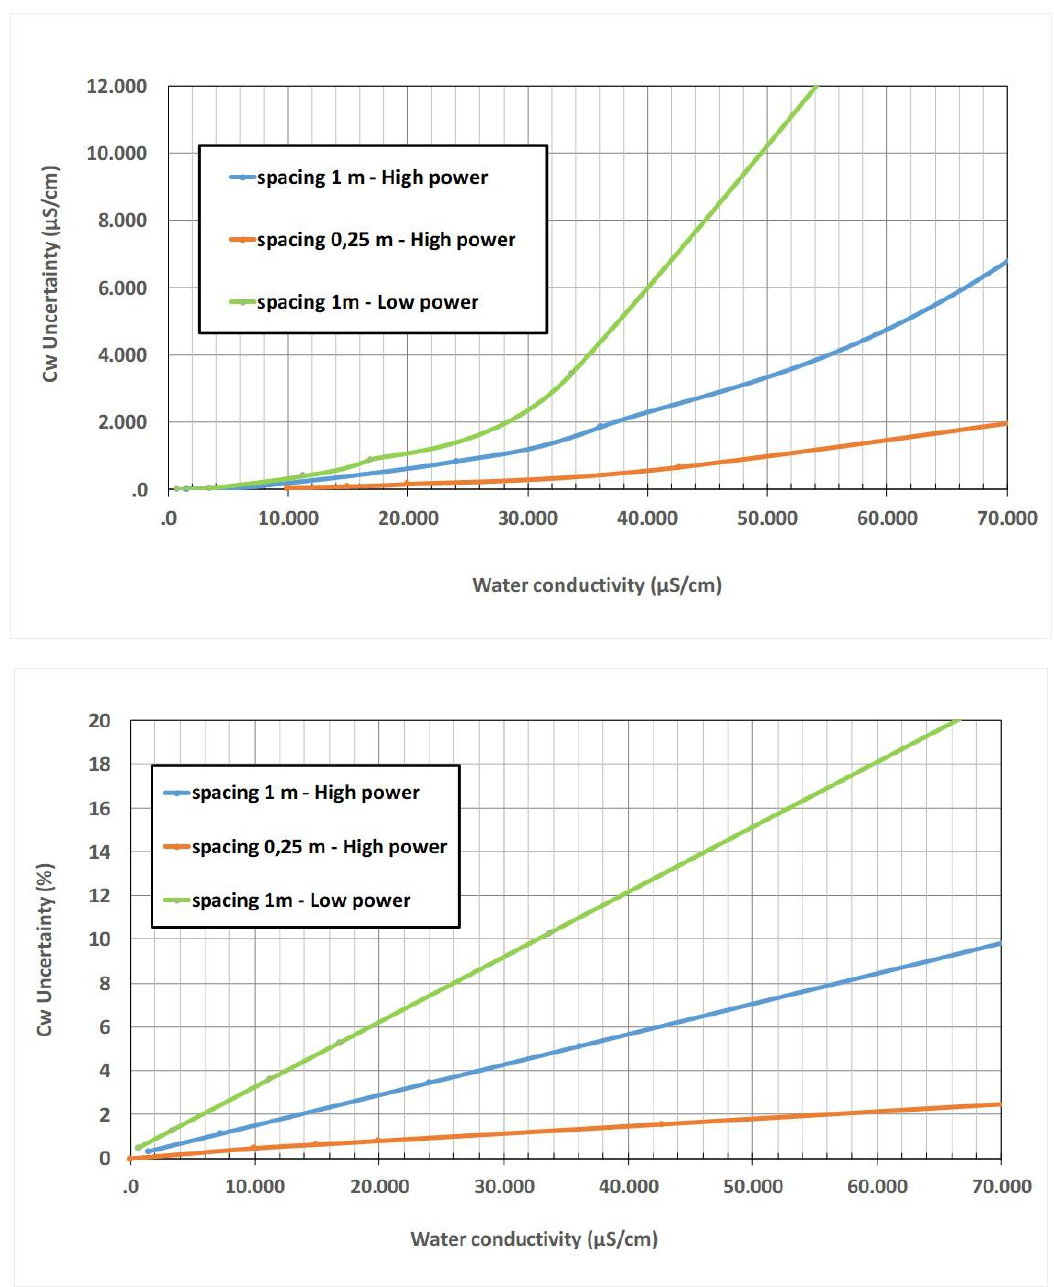
Figure 4. Water conductivity uncertainties versus water conductivity for different electrodes’ spacing and power injection; low figure in percent and top figure in water electric conductivity (EC) value.